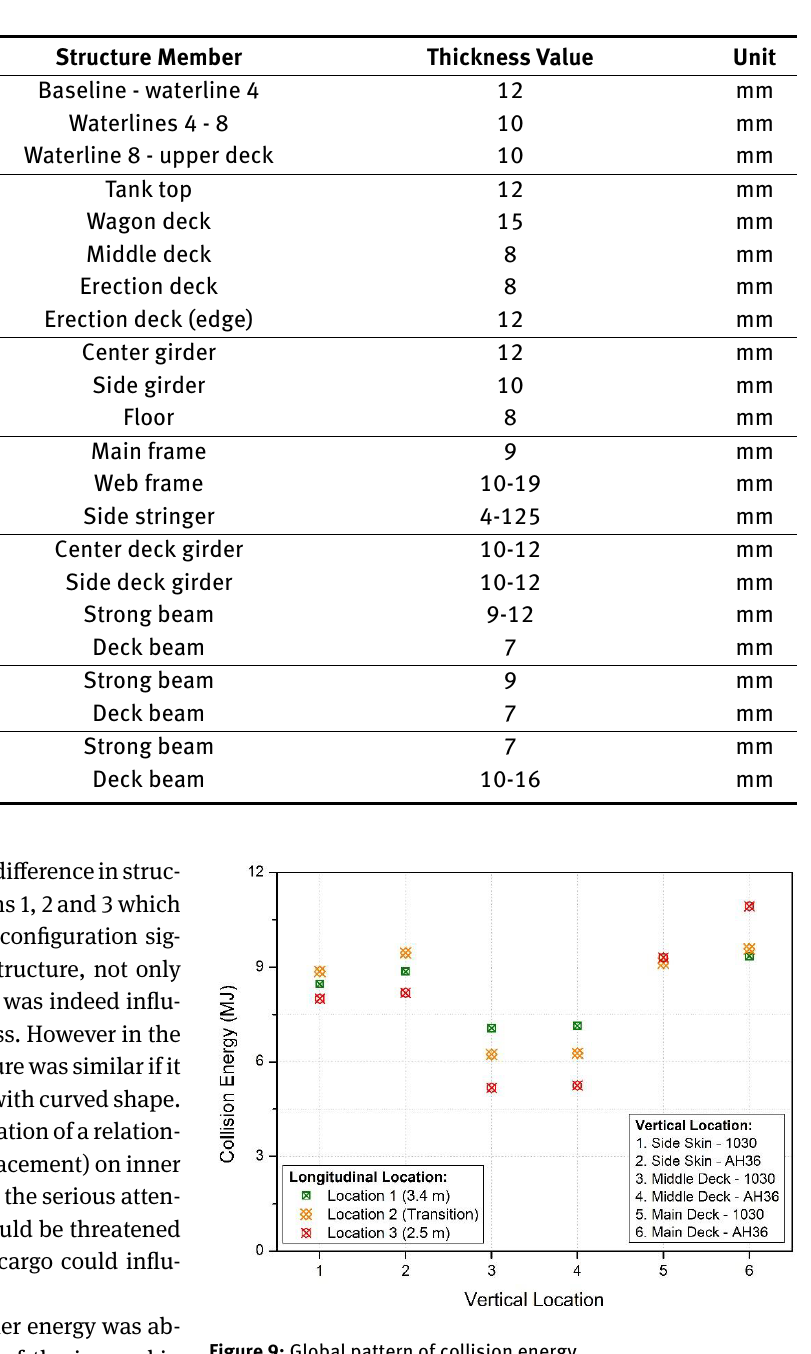
Figure 9: Global pattern of collision